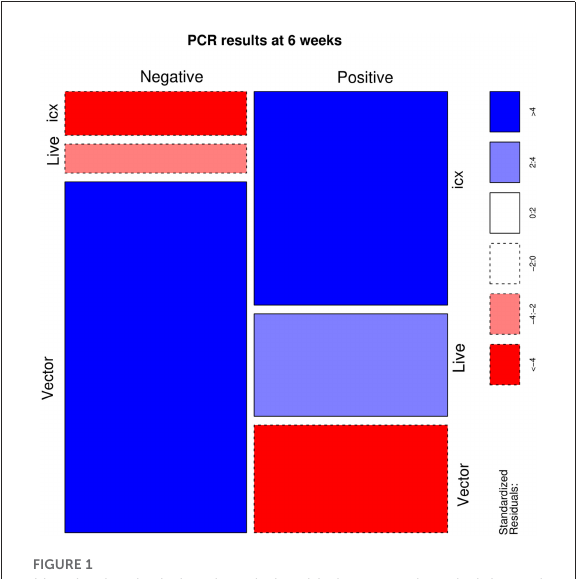
FIGURE1 Mosaic plot depicting the relationship between the administered vaccine and the results of PCR assay. The area of each cell is proportional to the count size. Cells have been color-coded and lines dotted based on standardized residuals (a standardized residual > 2 or < -2 is indicative of statistical significance).